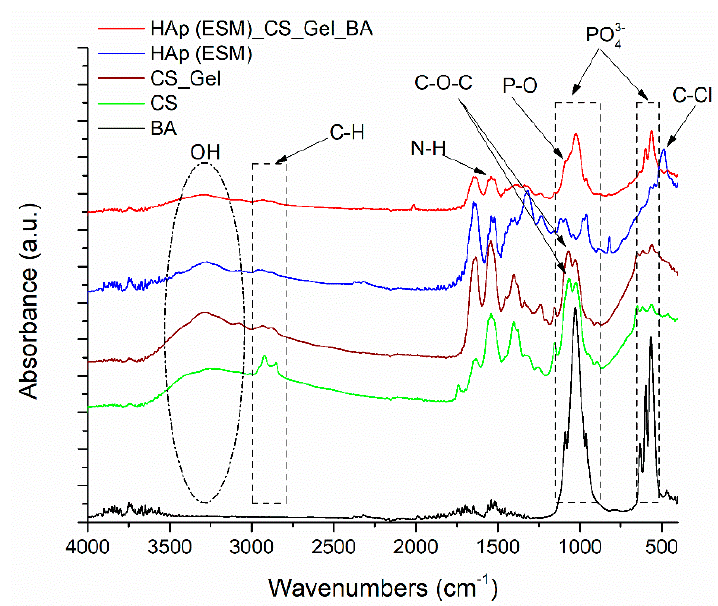
Figure 9. FT-IR spectra for the composite scaffold - HAp(ESM)_CS_Gel_BA.